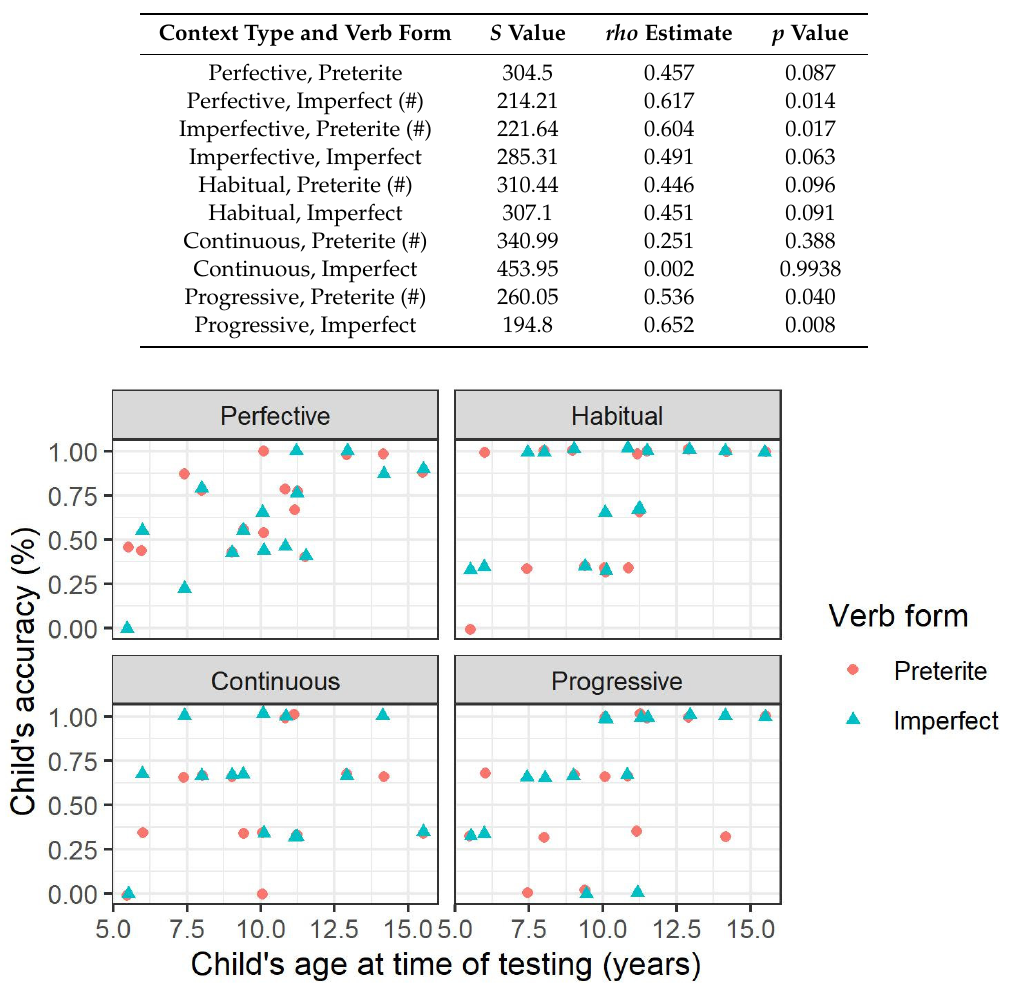
Table 7. Spearman’s rank correlations for children’s accuracy for each morpheme in each context and their age at time of testing.